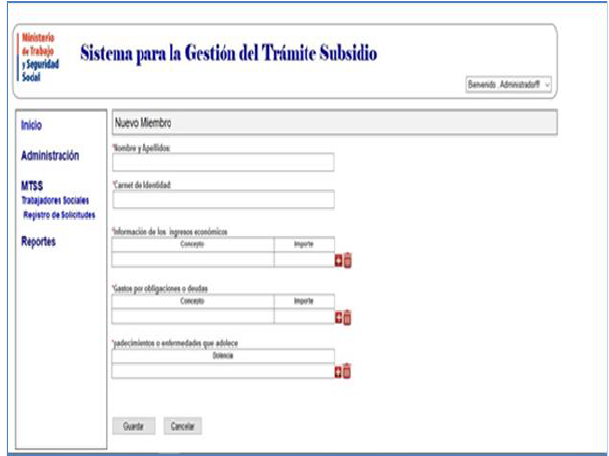
Fig. 5. Prototype 1: System to manage the Subsidy The student